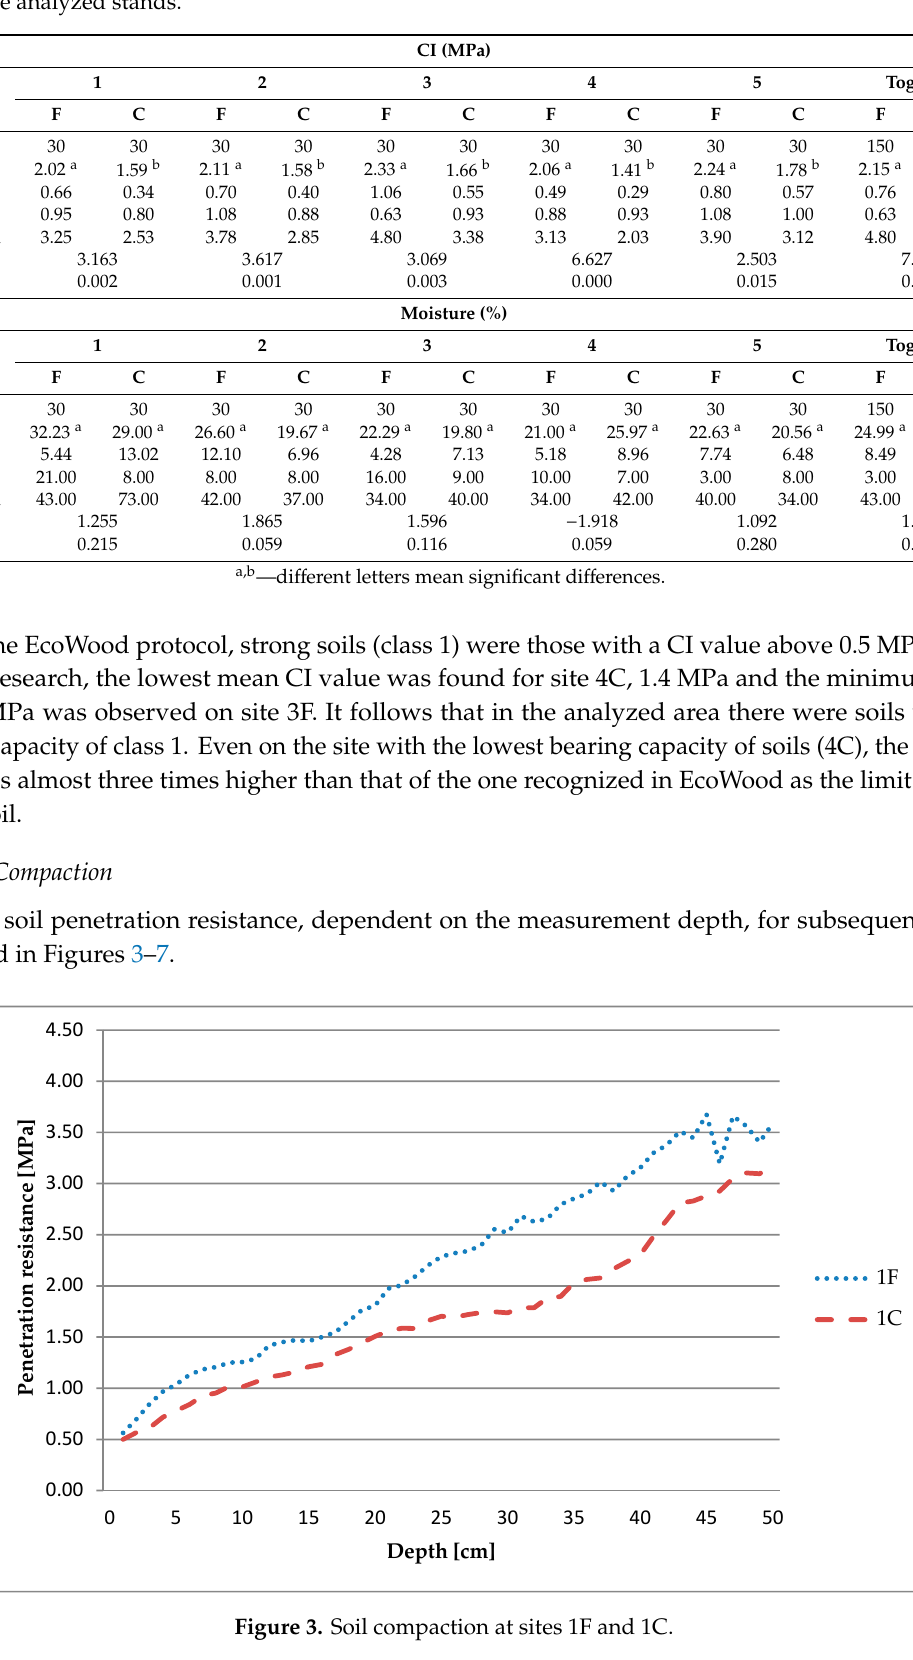
Table 2. The characteristics and significance of di ff erences in the cone index (CI) and moisture indicators in the analyzed stands.